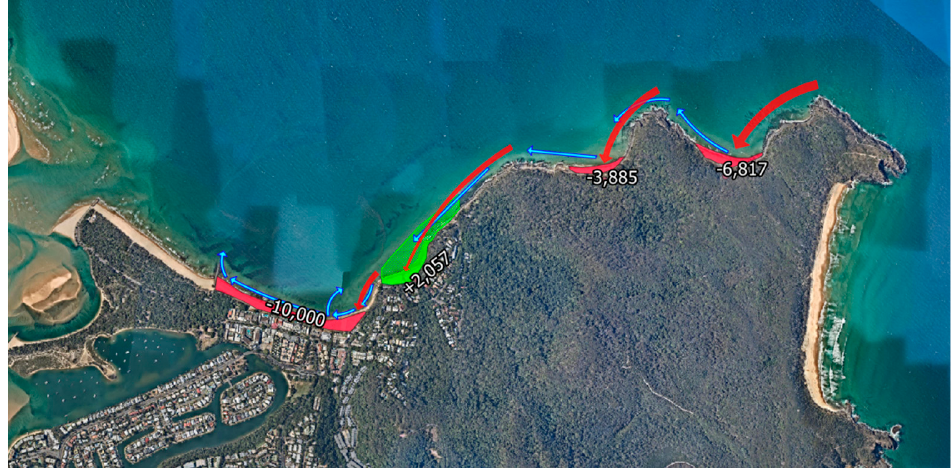
Figure 8. Conceptual model of erosion (red areas), accretion (green areas) and observed current flow directions (blue arrows) under progressively sheltered easterly (red arrow) storm wave conditions.